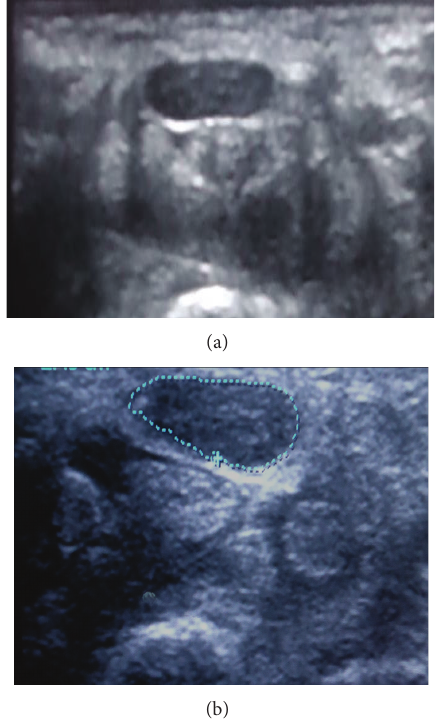
Figure 3: (a) Wrist ultrasound at the carpal tunnel inlet for patient with severe CTS medial, (b) the tracing method for measuring the cross sectional area of the median nerve which was 18mm 2 .